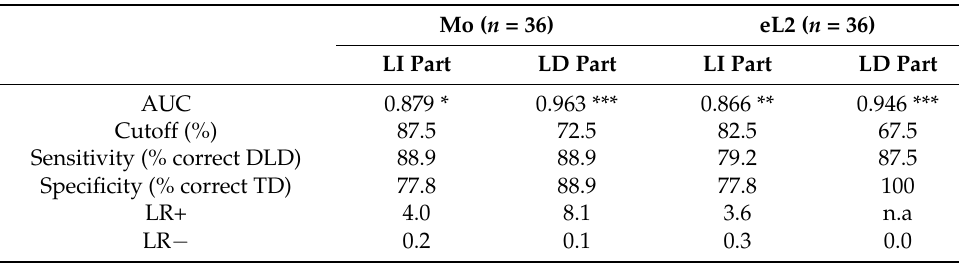
Table 7. Diagnostic metrics for the language-independent (LI) and the language-dependent part (LD) by acquisition